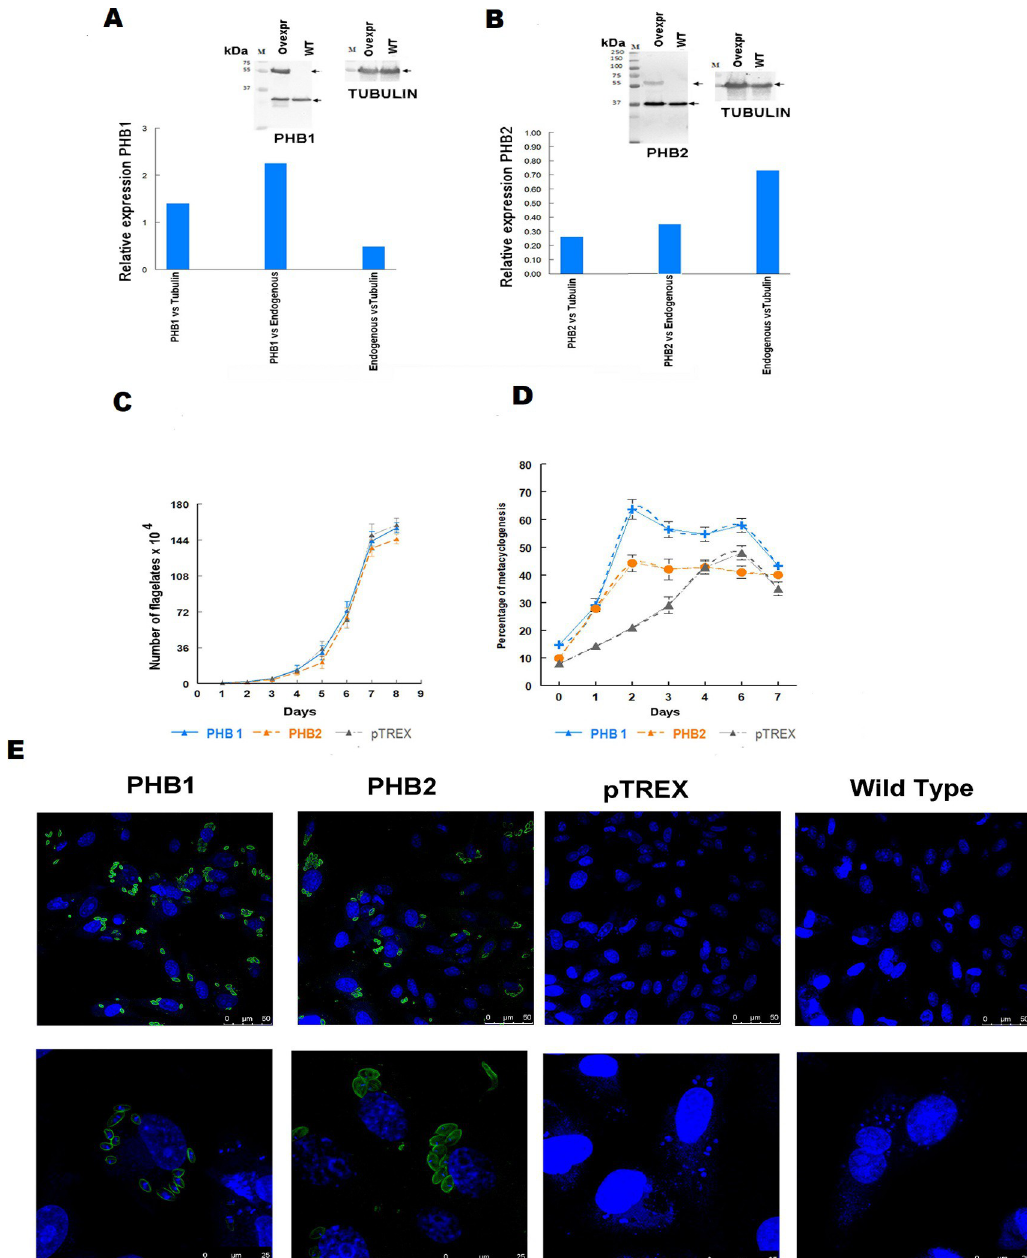
Fig 9. Overexpression of PHBs in different stages of T . cruzi . (A) Relative expression of recombinant PHB1 versus the endogenous PHB1 and tubulin in the epimastigote forms. (B) Relative expression of recombinant PHB2 versus the endogenous PHB2 and tubulin in the epimastigote forms. (C) Eight-day growth curves of the clones: T . cruzi (pTAPHB1) overexpressing the recombinant PHB1, T . cruzi (pTAPHB2) overexpressing the recombinant PHB2, and the control T . cruzi (pTAP). (D) Differentiation kinetics of epimastigotes into metacyclic trypomastigote forms of PHB recombinant cell lines. (E) Confocal microscopy of Vero cells 72 h post-infection with trypomastigotes of the recombinant cell lines. Anti-PHB1 and anti-PHB2 antibodies were used as the primary antibodies, and FITC anti-rat IgG antibodies (Sigma, Madrid, Spain) were employed as secondary antibodies. DAPI dye (blue) was employed as the DNA marker. T . cruzi . PHBs bind to the mitochondria membranes forming ring complexes that stabilize these organelles. PHB1/2 complexes are considered as a novel type of membrane-associated